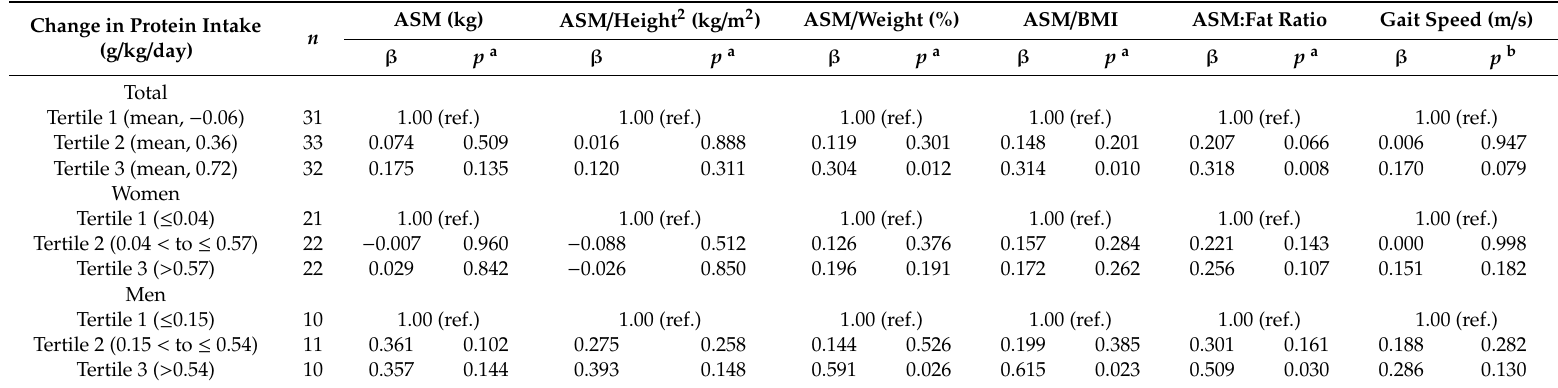
Table 3. Multiple linear regression analysis of changes in muscle mass and gait speed according to sex-specific tertiles of change in protein